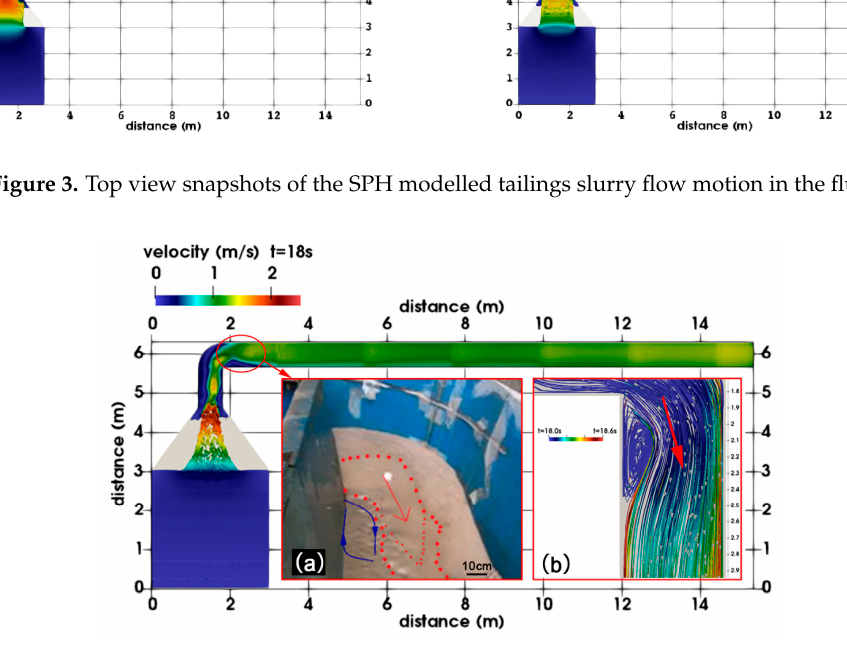
Figure 5. Comparison of slurry depth versus time at x = 6.5 m (from t = 1.6 s) and x = 9 m (from t = 3.8 s).